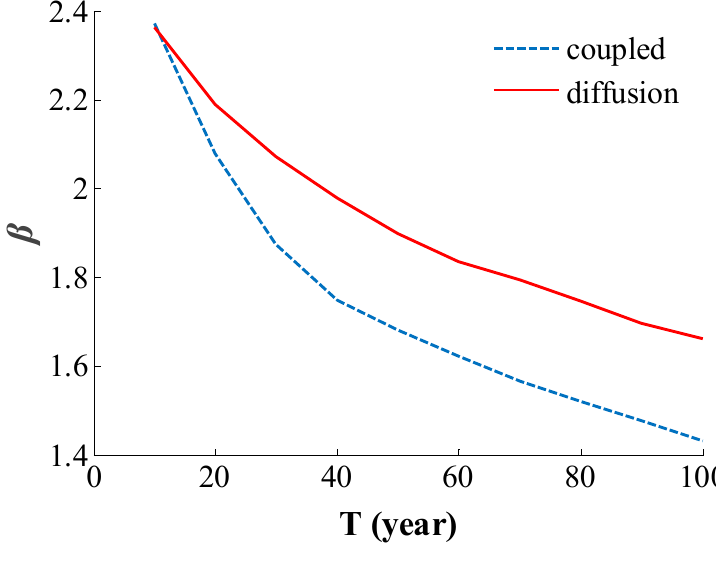
Figure 9. The time-varying reliability index of subsea tunnel.